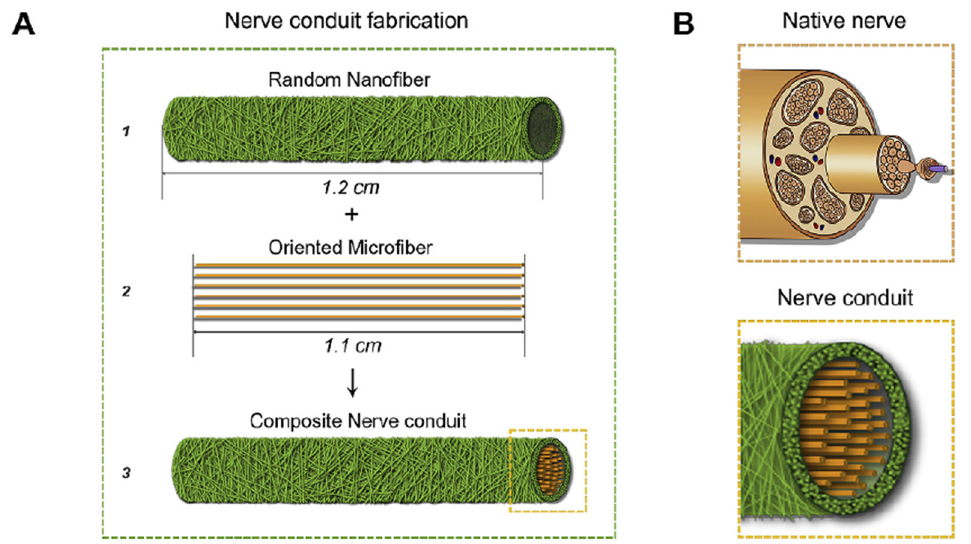
Figure 6. Preparation of nerve conduit and characterization of macrophage polarization on random nanofiber and oriented microfiber substrates. ( A , B ) Schematic illustration of natural nerve structure and biomimetic nerve conduit structure along with key fabrication steps. The conduits of A1 and A3 were respectively used for control and experimental groups. Reprinted (adapted) with permission from [46] © 2021 Elsevier Ltd. All rights reserved.